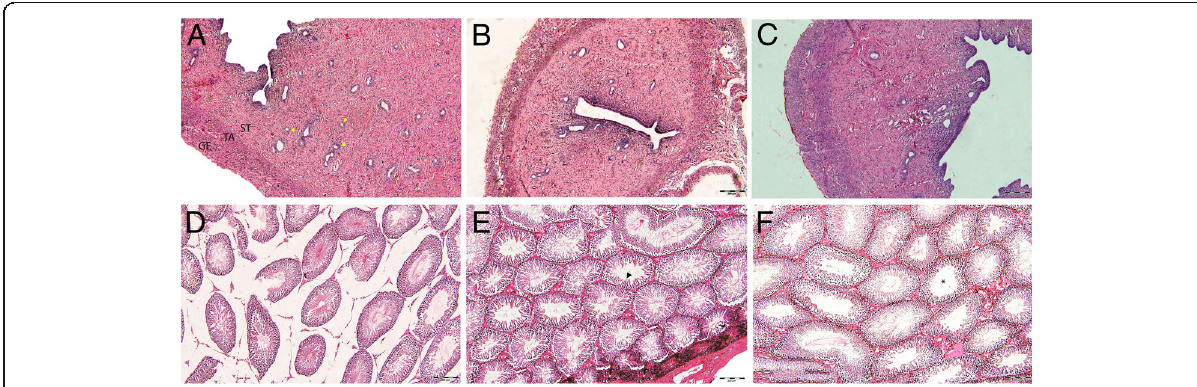
Fig. 4 Representative photomicrographs of gonadal structures of the experimental group. a – c Micrographs represents the testicular structure of a control group showing a normal histological appearance of tubules seminiferi; rats fed 50% GM food; b showing atrophy of seminiferous tubular, thinning of the tubule wall due to reduction in germ cells that make up tubular wall, the absence of spermatozoa in some tubule lumen (Black arrowhead) and c testis of 100% GM soybean meal group showing seminiferous tubule dilation is characterized by increased luminal diameter of the seminiferous tubules (black star). d – f Micrographs represents the ovarian structure of d control group showing a normal histology displaying from outside toward inside the germinal epithelium (GE), tunica albuginea (TA), stroma (ST), and many of the primordial follicles (yellow arrowhead); female rats fed 50% and 100% GM food ( e ) and ( f ) respectively, showing normal histology and lesser number of primary and secondary follicles. H & E stain, scale bar is 200 μ